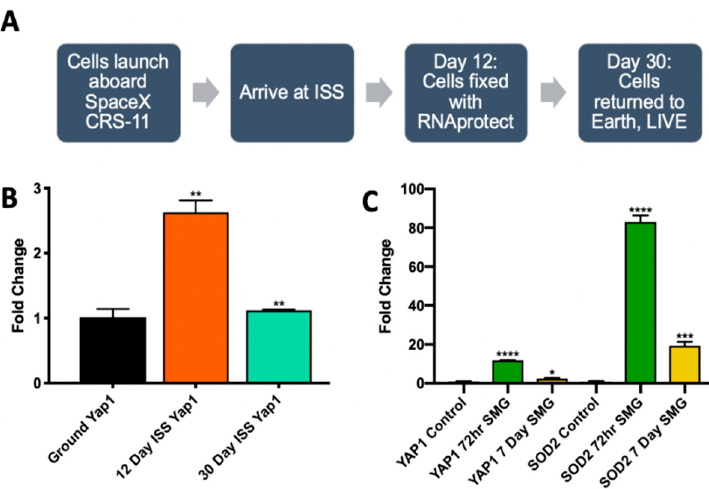
Figure 3. Human cardiac progenitor cells were launched into space and cultured aboard the International Space Station (ISS). Cells were fixed at 12 days or allowed to grow for 30 days before being returned to earth and fixed in RNAprotect ( A ). The expression of YAP1 in adult CPCs cultured aboard the ISS was increased after the 12-day time point and declined at 30 days ( B ). Similarly, adult CPCs cultured in simulated microgravity conditions expressed higher levels of YAP1, as well as the downstream target SOD2 ( C ) ( n = 4 at 72 h, n = 3 at 7 days, representative sample shown in the figure). * p < 0.05, ** p < 0.01, *** p < 0.001, **** p < 0.0001. Fold changes are shown as the mean ± SEM. All samples were run in